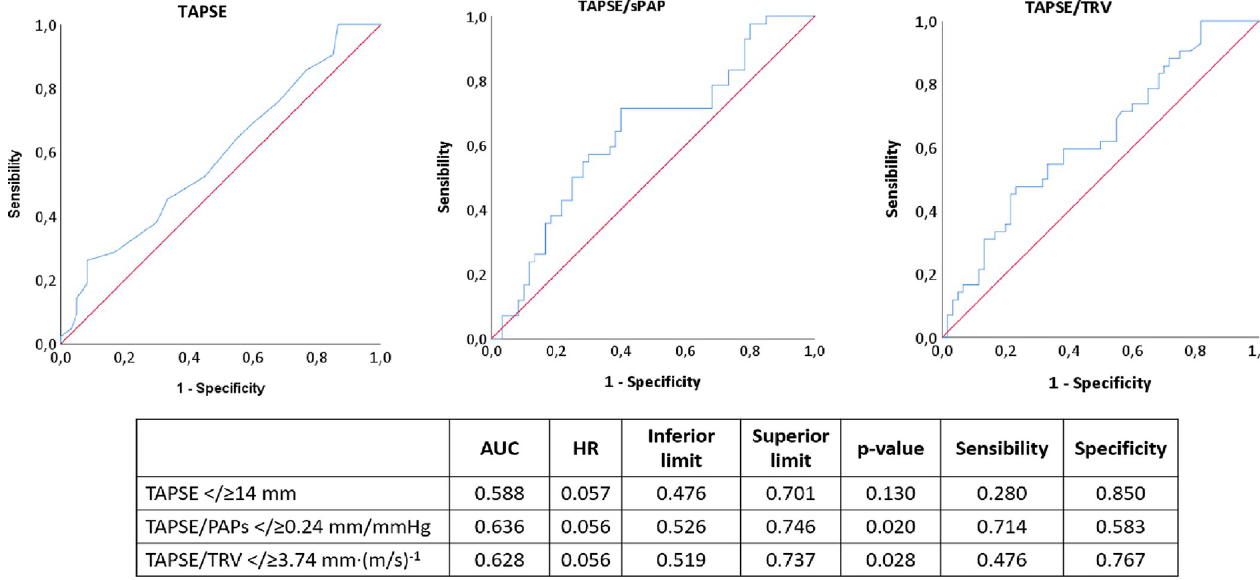
Fig 3. ROC analysis of TAPSE, TAPSE/sPAP, and TAPSE/TRV according to the optimal cut-point calculated with Contal and O’Quingley analysis.